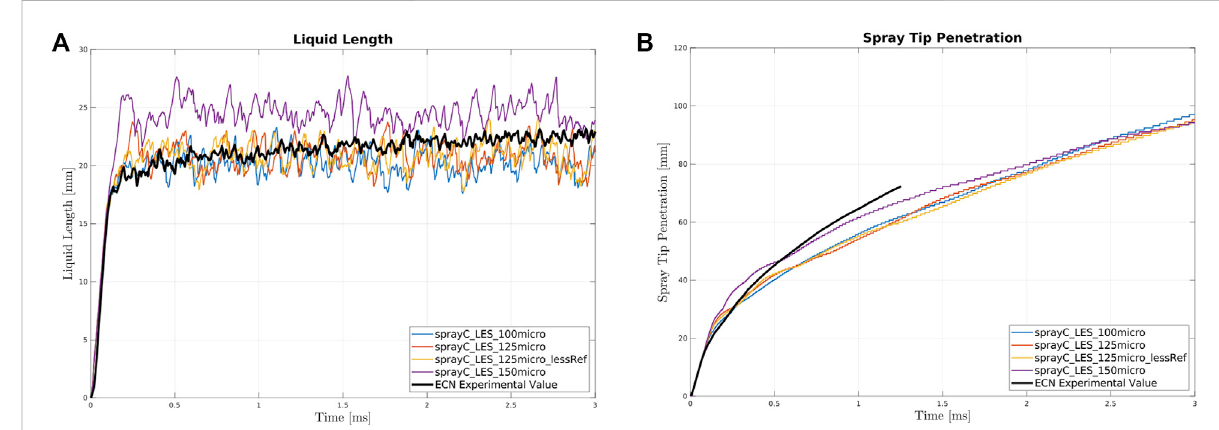
FIGURE 4 Liquid Length (A) and Spray Tip Penetration (B) for Spray C at various mesh